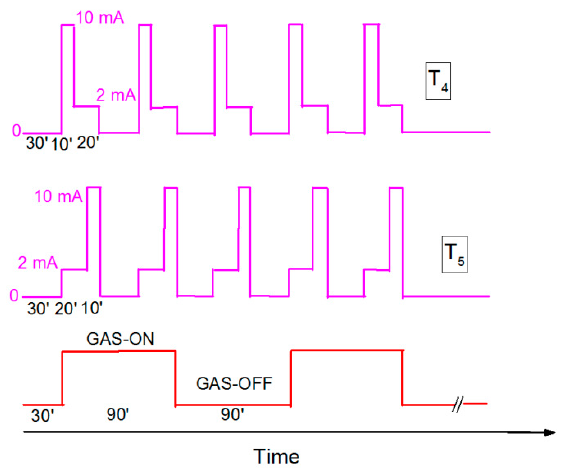
Figure 6. The PWM sequences named T 4 and T 5 , and gas-sampling sequence.